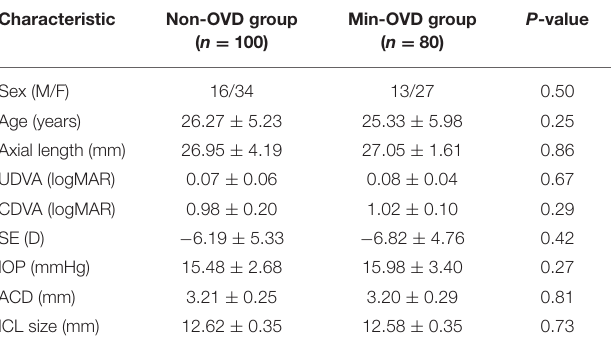
TABLE 2 | Biometric data of subjects at baseline.